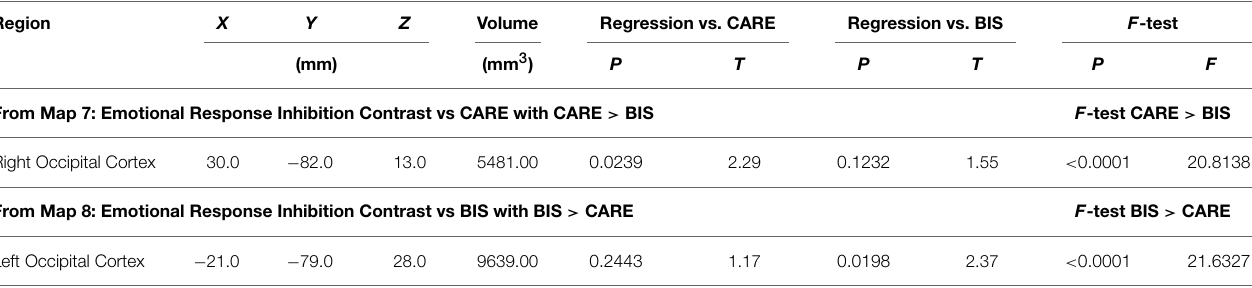
TABLE 5 | Summary of significant regions from Maps 7 and 8. Region X Y Z Volume Regression vs. CARE Regression vs. BIS F -test (mm) (mm 3 ) P T P T P F From Map 7: Emotional Response Inhibition Contrast vs CARE with CARE > BIS F -test CARE > BIS Right Occipital Cortex 30 . 0 − 82 . 0 13 . 0 5481 . 00 From Map 8: Emotional Response Inhibition Contrast vs BIS with BIS > CARE F -test BIS > CARE Left Occipital Cortex − 21 . 0 SummaryofsignificantregionsfromMaps7and8.Map7testedcomparisonoffMRIemotionalresponseinhibitioncontrast(aversiveNoGo − aversiveGo)vs.CAREscoreswhereCARE scores also accounted for more variance than BIS scores. Map 8 tested regression of emotional response inhibition contrast vs. BIS scores where BIS scores also accounted for more variance than CARE scores. X, Y, Z: MNI coordinates of region’s peak statistical voxel. P- and t-values are median values across all voxels in each region (df = 98). F-test CARE > BIS values are median values across each region from the F-map testing whether CARE scores accounted for significantly more variance in emotional response inhibition contrast values than BIS scores (df = 1, 97). F-test BIS > CARE shows median values from the F-map testing whether BIS scores accounted for significantly more variance in emotional